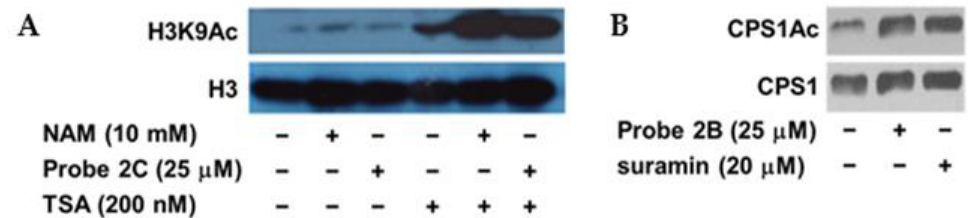
Figure 6. Probes 2B and 2C are cell permeable sirtuin inhibitors. ( A ) Western blot showing increased acetylation level of H3K9 (H3K9Ac) in HEK293 cells treated with probe 2C; ( B ) Incubation with probe 2B or suramin increased CPS1Ac level in HEK293 cells.